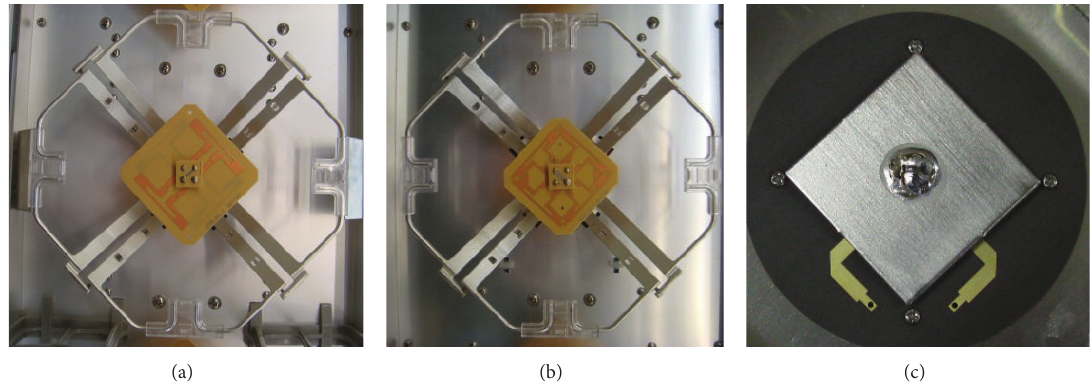
Figure 7: Top view of fabricated radiators for multiband base-station antenna: (a) Band 1 + Band 2, (b) Band 1 + Band 3, and (c) Band 4.